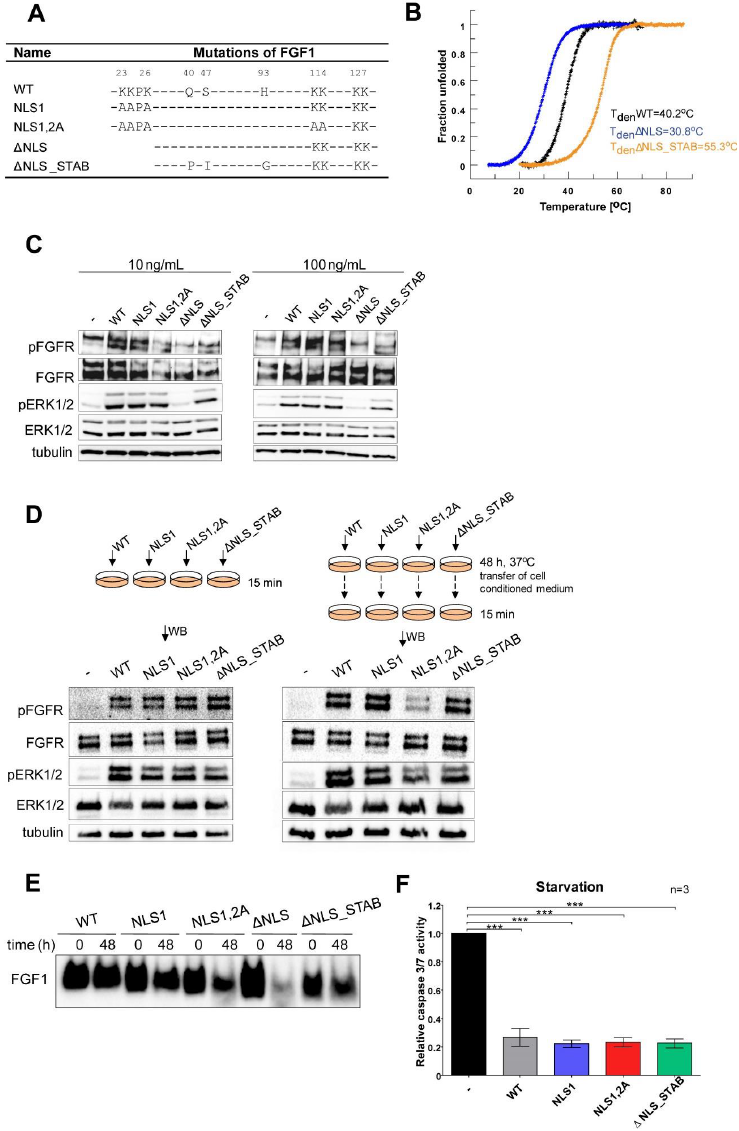
Figure 1. Stability and functional activity of NLS variants of FGF1. ( A ) Wild type (WT) and mutational variants of FGF1 used in the study. ( B ) Normalized thermal denaturation curves of FGF1